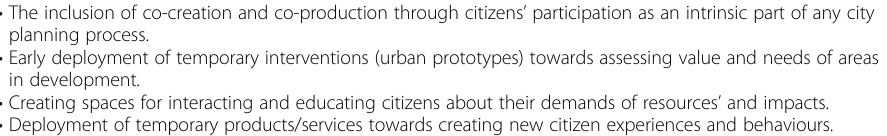
Table 5 Guidelines towards helping cities become a ‘ healthy city ’ (cid:129) The inclusion of co-creation and co-production through citizens ’ participation as an intrinsic part of any city planning process. (cid:129) Early deployment of temporary interventions (urban prototypes) towards assessing value and needs of areas in development. (cid:129) Creating spaces for interacting and educating citizens about their demands of resources ’ and impacts. (cid:129) Deployment of temporary products/services towards creating new citizen experiences and